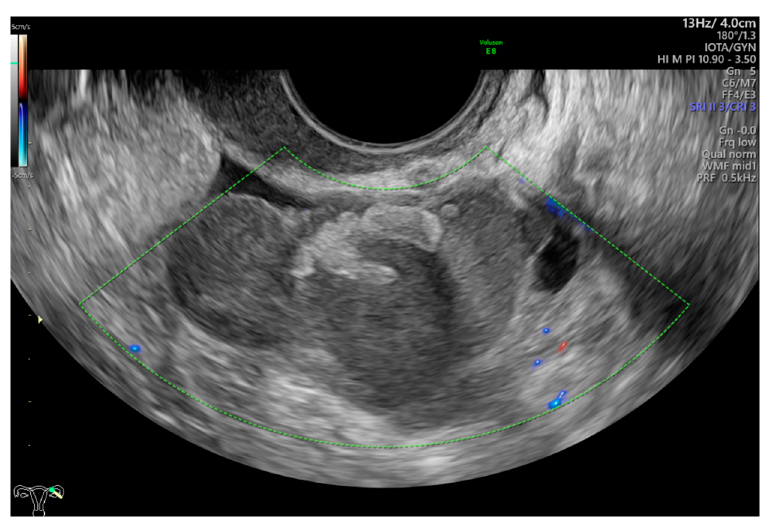
Figure 1. Complex morphology adnexal cyst with mixed echostructure and acoustic shadowing within the cyst. The lack of vascularity indicates IOTA color score of 1. Final histology: benign endometrioma.